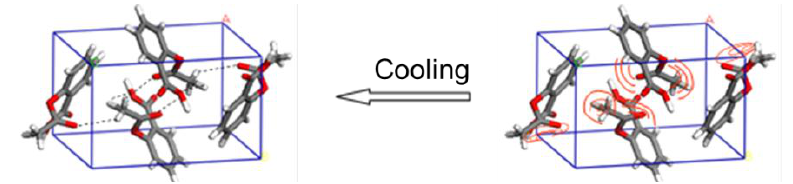
Figure 9. The temperature-dependent behavior of weak bonds in